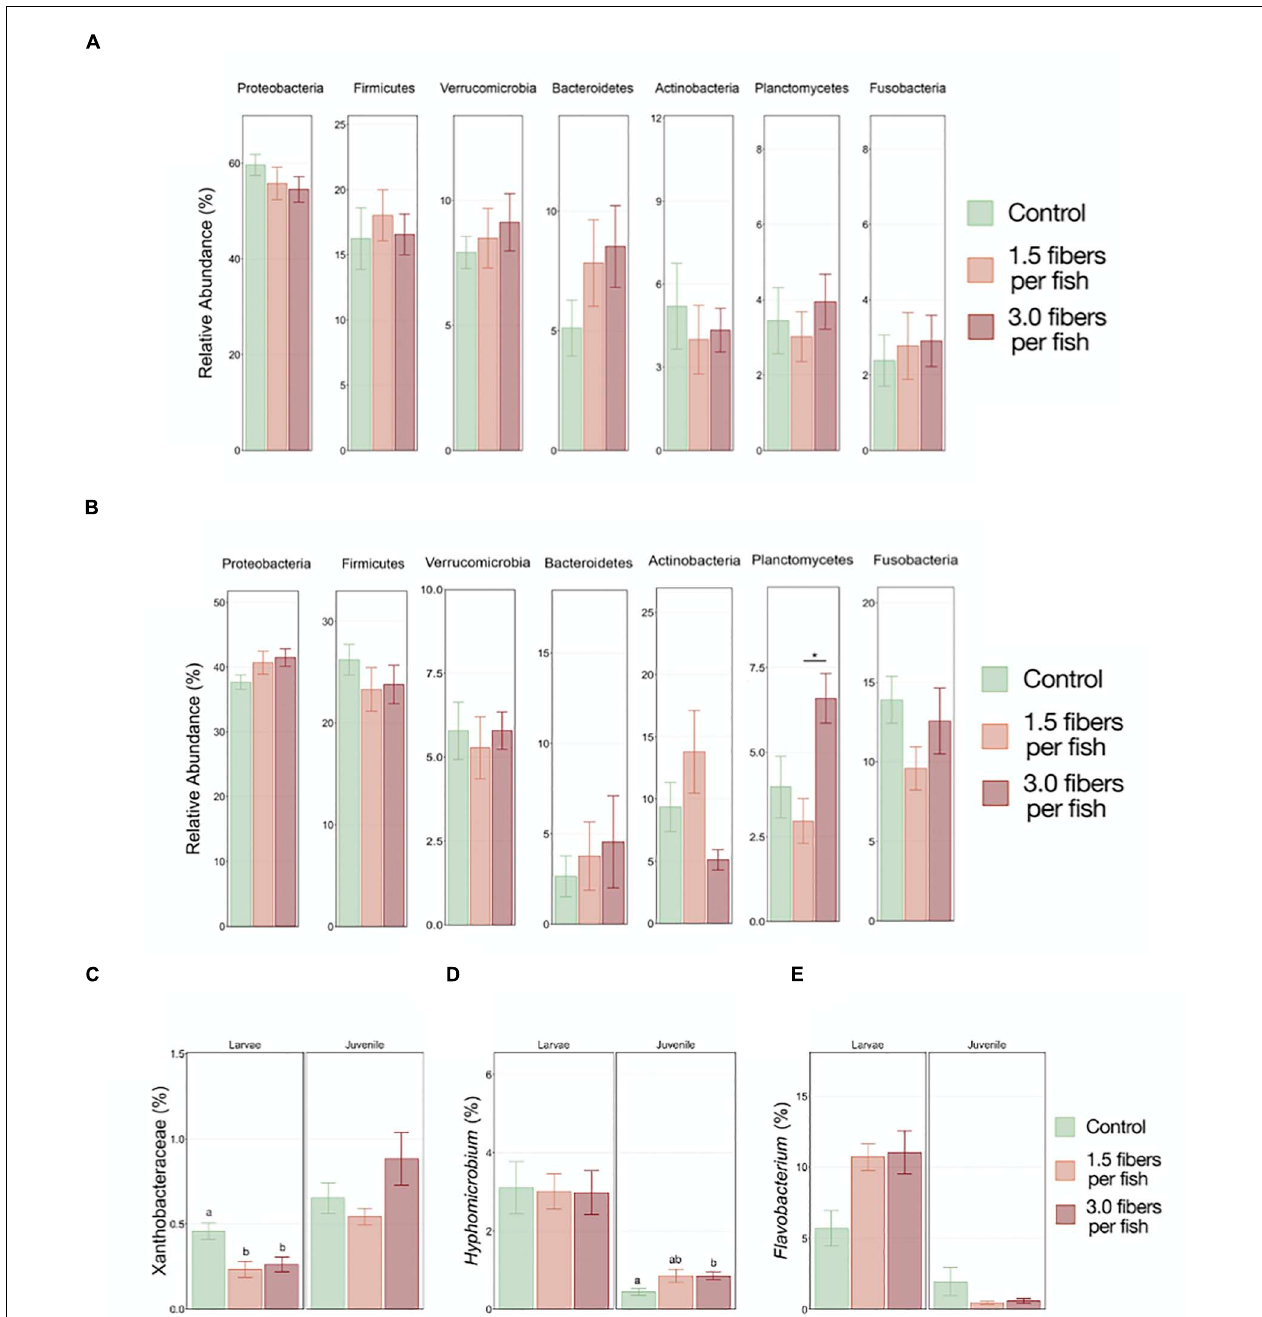
FIGURE 4 | Comparison of the top seven most abundant gut microbiome phyla in larvae (A) and juvenile (B) O. latipes from the control, 1.5, and 3 fibers/fish/day exposure groups. Abundance of (C) Xanthobacteraceae (Proteobacteria), (D) Hyphomicrobium (Proteobacteria) and (E) Flavobacterium (Bacteroidetes) in larval and juvenile samples are depicted. Stars indicate statistically significant differences between treatment groups; different letters indicate statistically significant differences between control and treatment groups with (Kruskal–Wallis Test, p < 0.05; n =